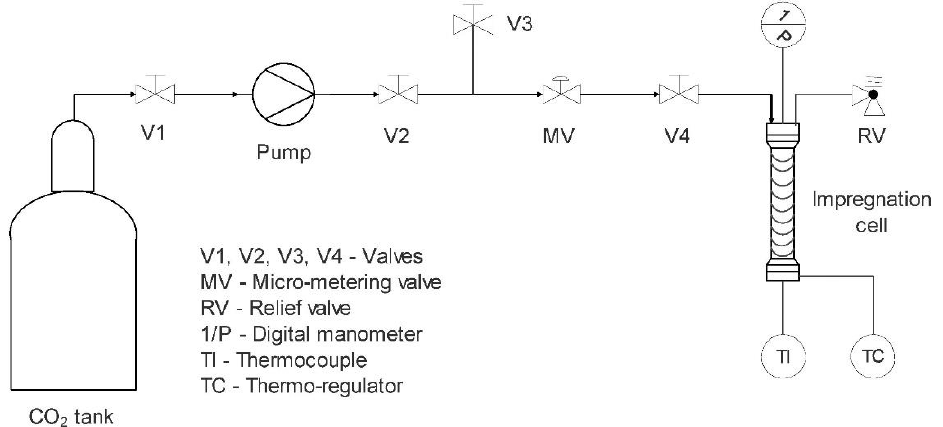
Figure 6. A schematic diagram of SSI apparatus [102]. Reprinted from the Journal of Non-Crystalline Solids, 432, Pantić et al., Supercritical impregnation as a feasible technique for entrapment of fat- soluble vitamins into alginate aerogels, 519 – 526, Copyright (2016), with permission from Elsevier. Usually, the loading of the AI into the polymer is determined, and the impregnation efficiency is evaluated using the partitioning coefficient K, which indicates the relative